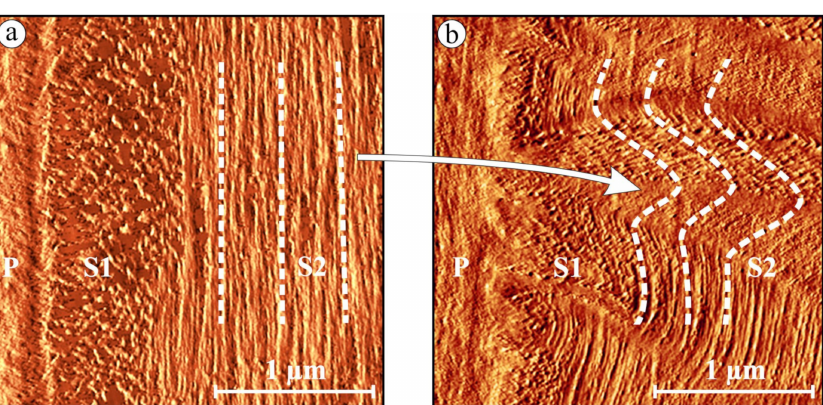
Figure 17. ( a ) Atomic force microscopy images on radial sections of an oak wood cell wall in an untreated specimen and ( b ) in a compressed specimen exposed to a fixation for a long time. The images show the primary cell wall (P), the layers of the secondary cell wall (S1 and S2), and the corresponding microfibril direction in the S2 layer with dotted lines. The arrow symbolises the compression process, what the cell wall looked like before and what it looked like after. Reproduced from [119], licensed under CC BY